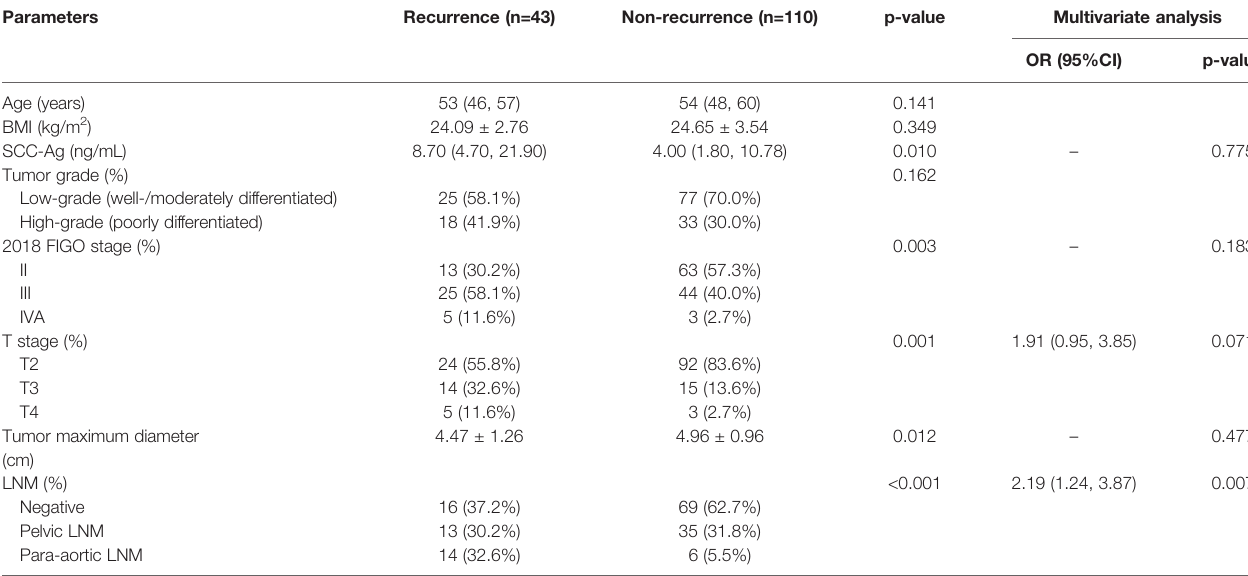
TABLE 3 | Comparison of clinical variables between recurrence and non-recurrence groups in the training cohort. Parameters